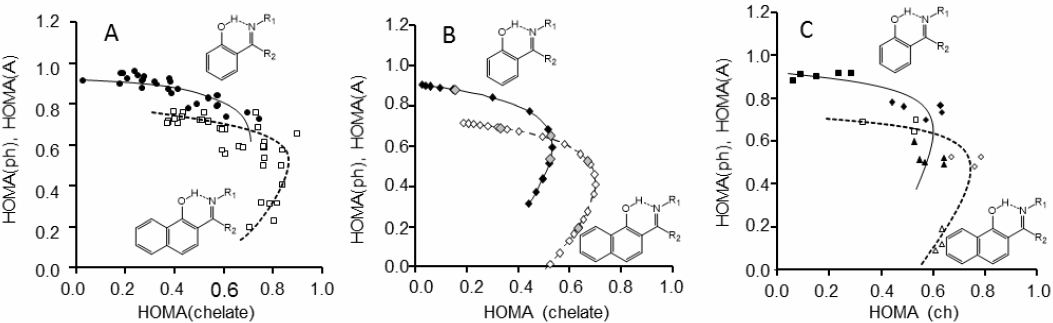
Figure 12. Dependencies of the HOMA aromaticity index of phenyl ring (HOMA(ph)) (solid line) and naphthalene (HOMA(A)) (dotted line) on the changes of aromaticity of chelate chain (HOMA(ch)) obtained from the experimental data ( A ); calculated with non-adiabatic approach for 2-[(1 E )- N - methylethanimidoyl]phenol (R 1 = R 2 = CH 3 ) and 2-[(1 E )-1-(methyliminio)ethyl]-naphthalen-1-olate (R 1 = R 2 = CH 3 ) molecules ( B ) and for fully optimised tautomeric form ( C ).